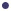
Scatter plots of five water parameters measured by Citizen Science Leaders (CSLs) and the Environmental Protection Department of Hong Kong (EPD) between 2014 and 2015.The CSL monitoring sites (represented by solid-filled symbols, ●) were about 100 m apart from EPD monitoring sites (represented by hollow symbols, ○).